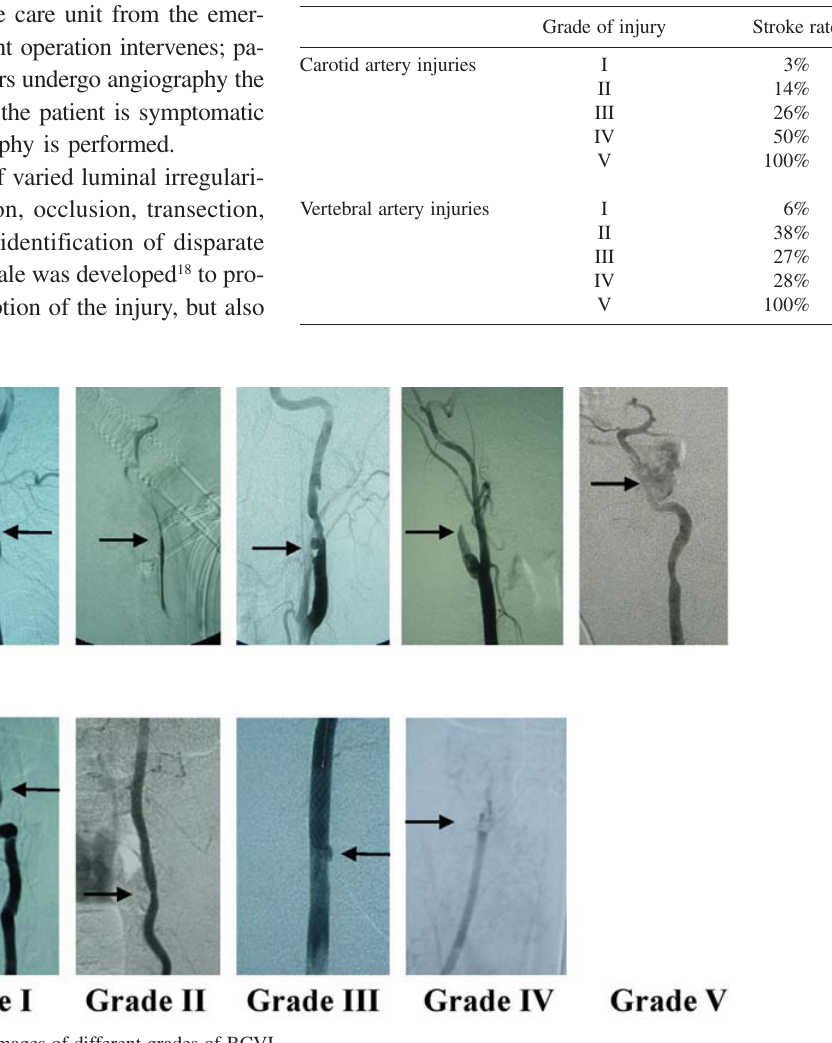
Figure 1 - Representative angiographic images of different grades of BCVI Injury Grade: Angiographic Finding; Grade I: Intimal Irregularity, <25% Luminal Stenosis; Grade II: Intimal Irregularity, >25% Luminal Stenosis, Intimal Flap; Grade III: Pseudoaneurysm; Grade IV: Occlusion; Grade V: Transection with active